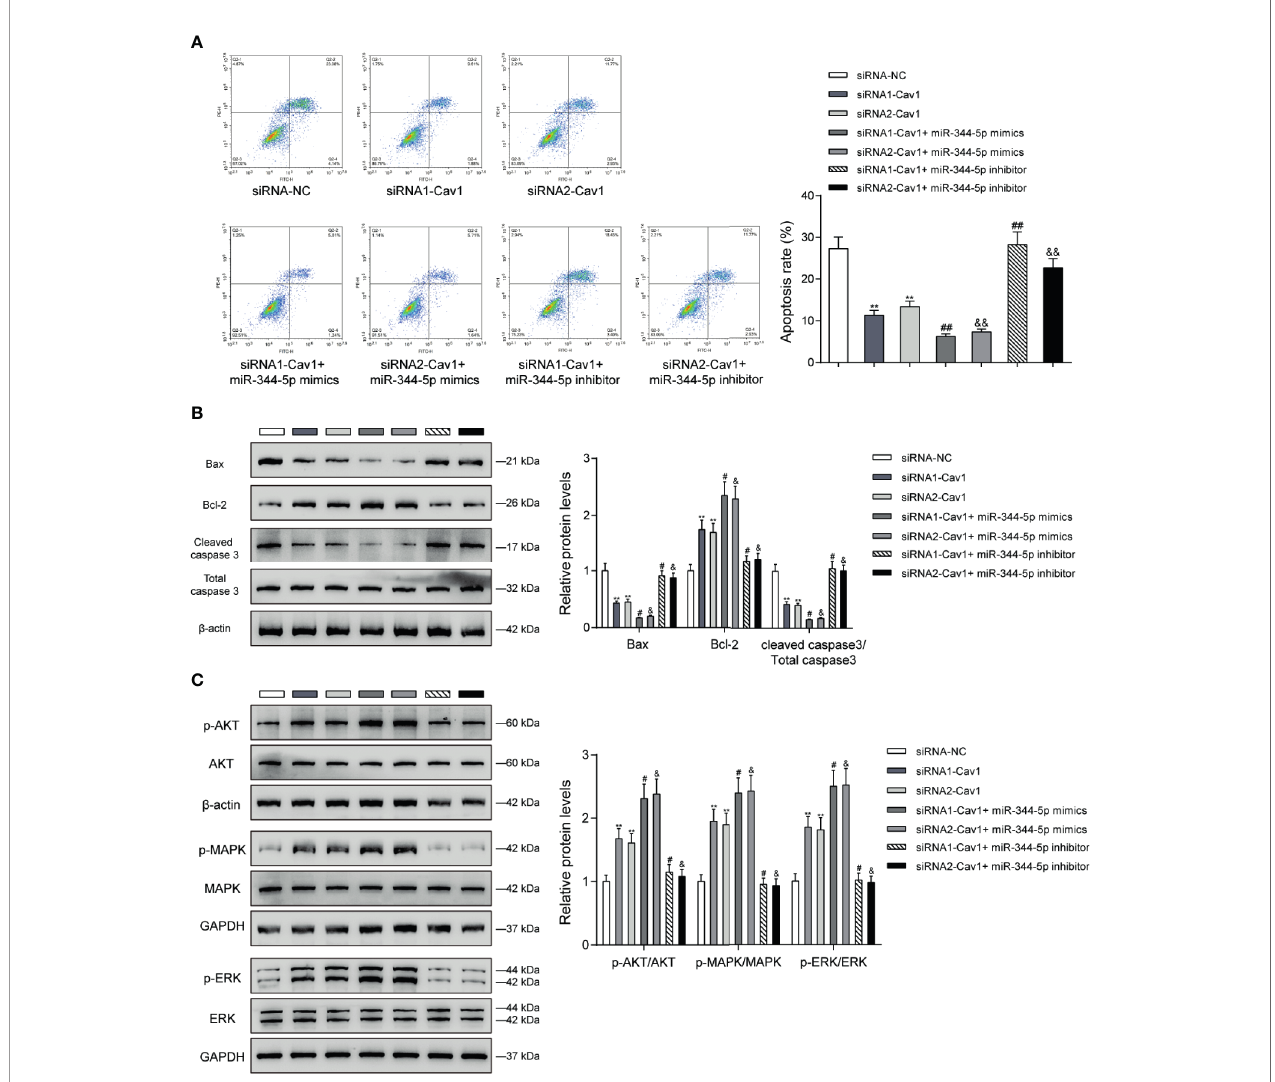
FIGURE 6 | The miR-344-5p/Cav1 axis affects cholesterol-induced b -cell dysfunction through the apoptosis and MAPK/ERK signaling. INS-1 cells were divided into seven groups as described above and were transfected accordingly, treated with 5 mM cholesterol for 12 h, and examined for cell apoptosis by Flow cytometry assay (A) ; the protein levels of Bax, Bcl-2, and cleaved-caspase 3 by immunoblotting (B) ; the protein levels of p-AKT, AKT, p-MAPK, MAPK, p-ERK, and EKR by immunoblotting (C) . b -actin and GAPDH were applied as an endogenous control. ** P < 0.01 compared to siRNA-NC; # P < 0.05 compared to siRNA1-Cav1 group; & P < 0.05 compared to siRNA2-Cav1 group. ## p < 0.01, && p <